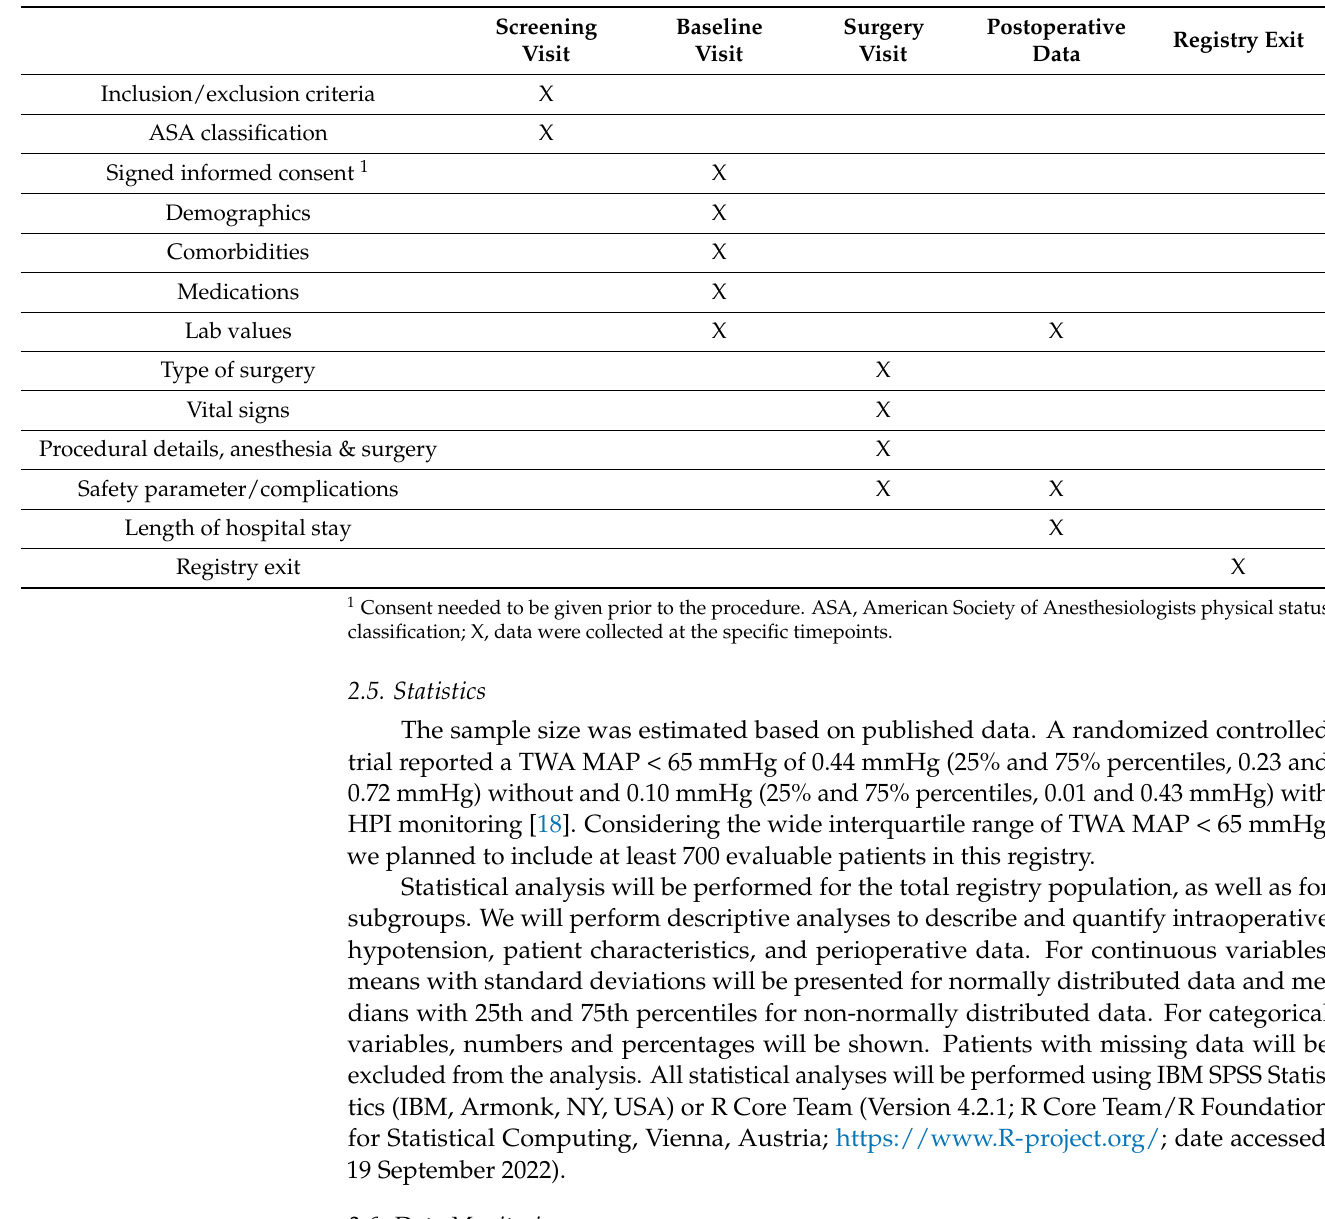
Table 2. Data collection